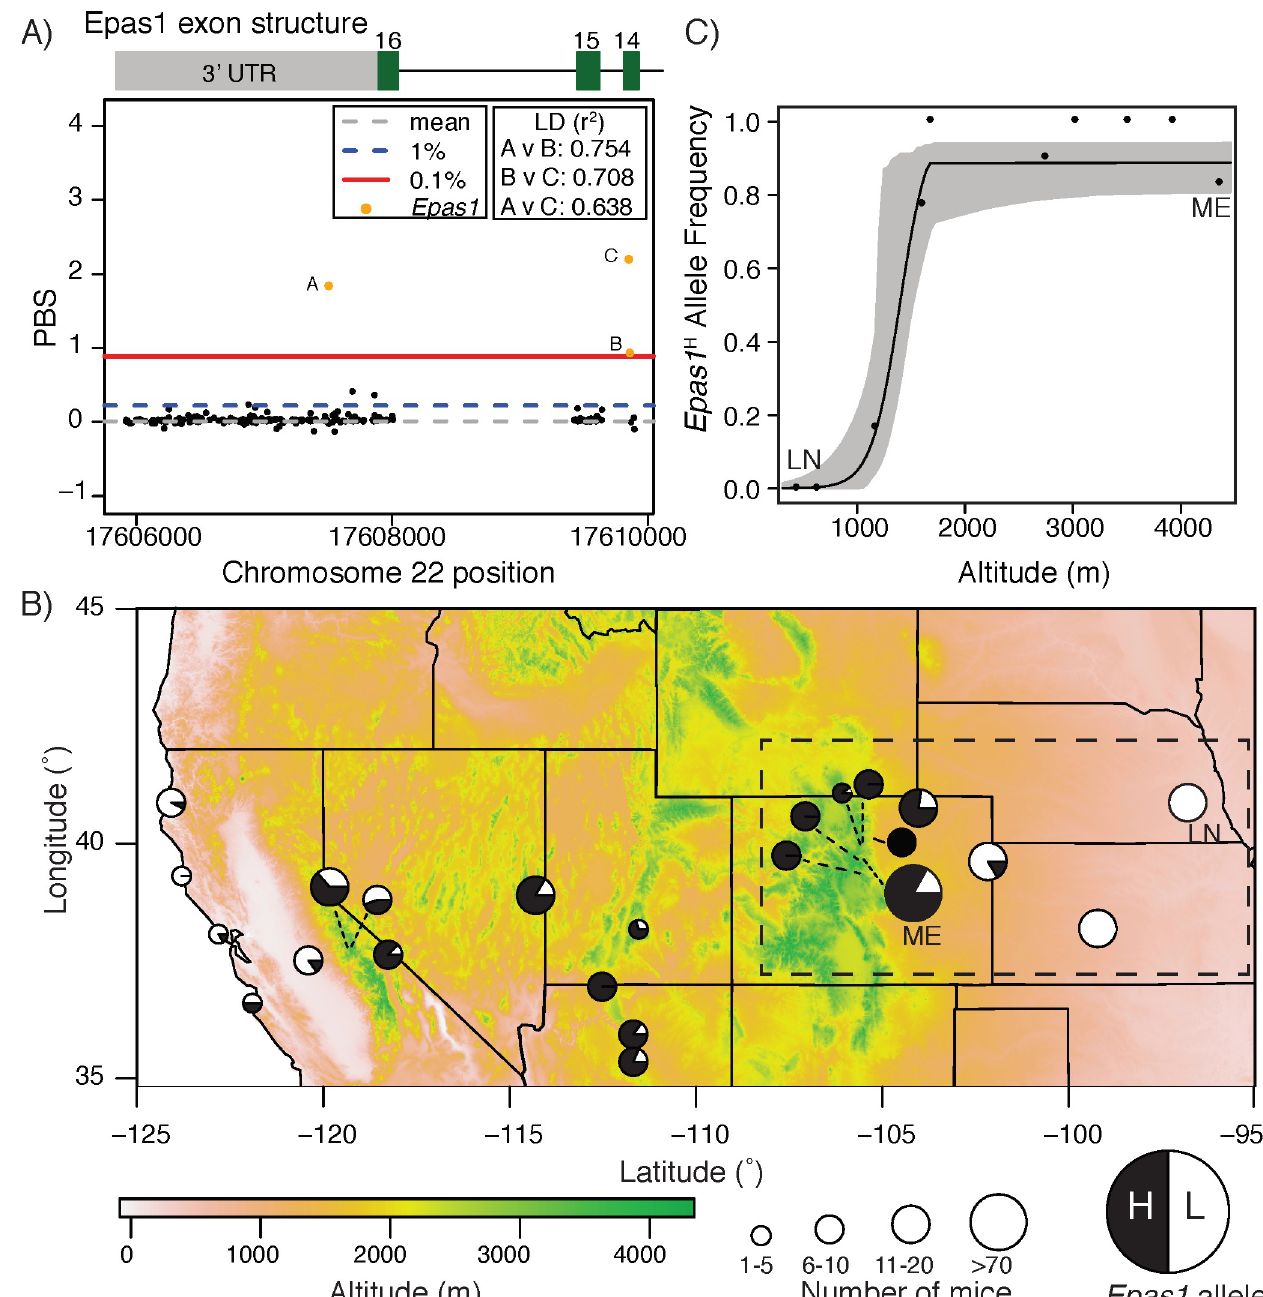
Fig 1. Epas1 is an exome-wide outlier under spatially varying selection in P . maniculatus along altitudinal gradients. A) Manhattan plot of PBS values for all SNPs (black dots) located within the last three exons of Epas1 (exon numbers provided above schematic). Exome-wide values for mean, top 1%, and top 0.1% percentile PBS values are shown, and three outlier SNPs in Epas1 are highlighted in orange (see key). Pairwise linkage disequilibrium estimates (measured with the squared correlation coefficient, r 2 ) for each SNP pair are provided. B) Geographic variation in Thr 755 Met Epas1 allele frequency for 23 populations in the Rocky Mountains and Great Plains, USA. Pie charts are shaded according to frequency of high-altitude or low-altitude allele, with size indicating number of mice sampled (see key). C) Clinal variation in Thr 755 Met Epas1 allele frequency for 10 P . maniculatus populations sampled along a 4500 m altitudinal cline from the Great Plains of Nebraska to the Rocky Mountains in Colorado. In (B) and (C), Mt. Evans (ME) and Lincoln (LN) populations are labeled. Dashed box in (B) shows populations chosen for assessing clinal variation in (C). See S1 Table for details on sampling location and Epas1 allele